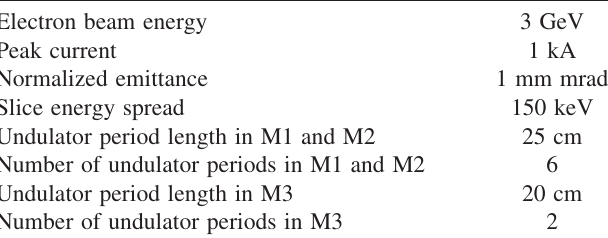
left).TABLE I. Main beam and undulator